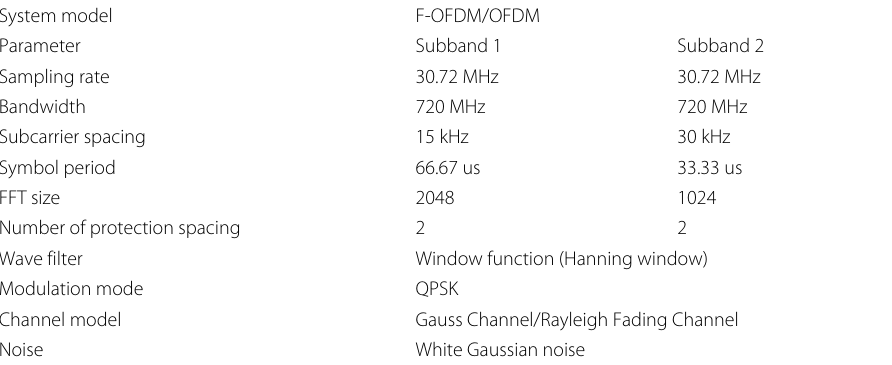
Table 1 Basic parameters of system